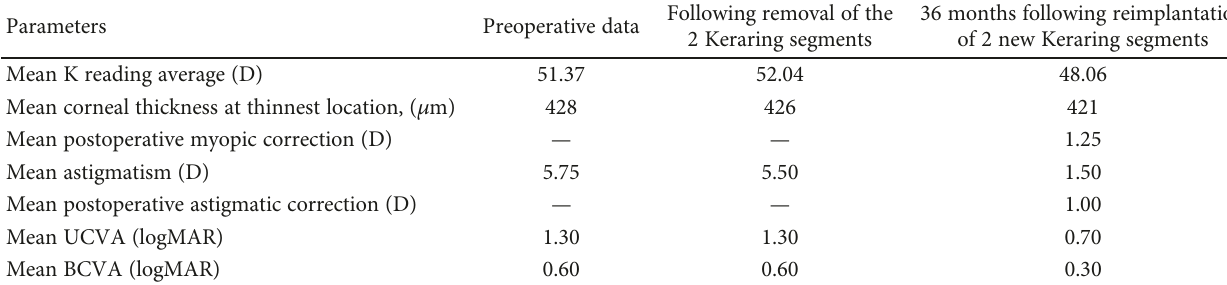
Table 5: The summary of the refractive data of the 7 th complicated eye (group C).